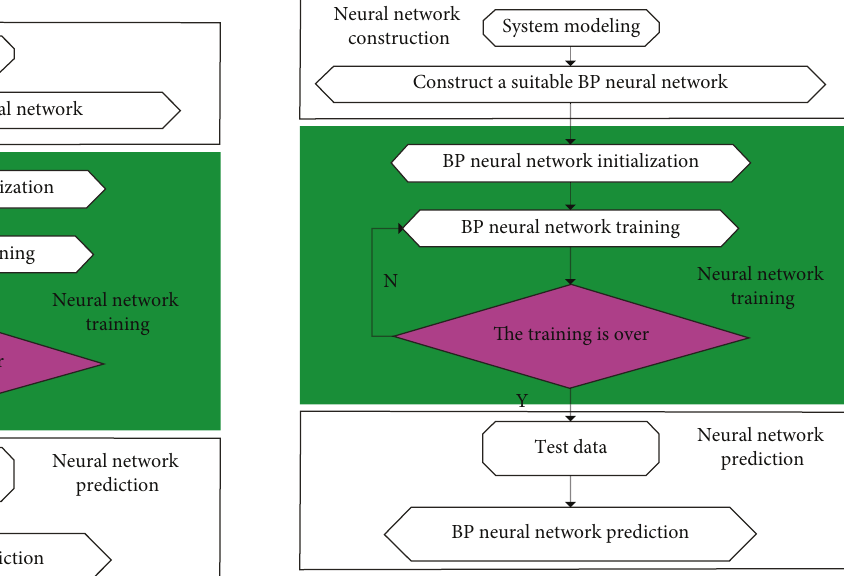
Figure 9: The modeling process of offline training of the neural